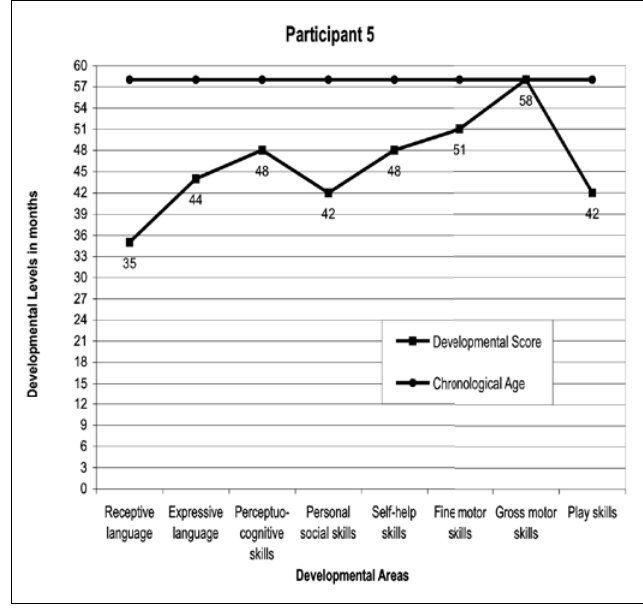
Fig. 5. Participant 5: Comparison between chronological age and participant’s level of developmental functioning.